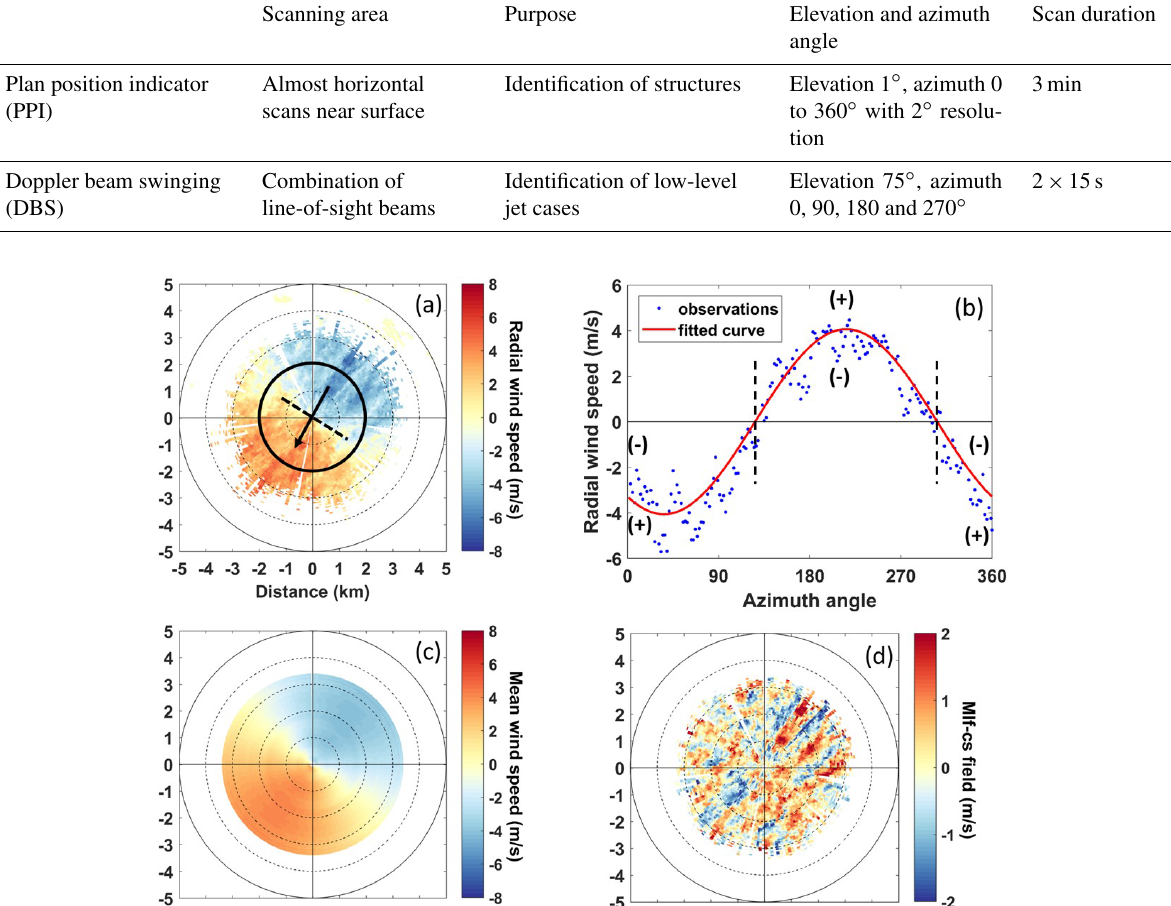
Table 2. Scanning methods selected during VEGILOT.